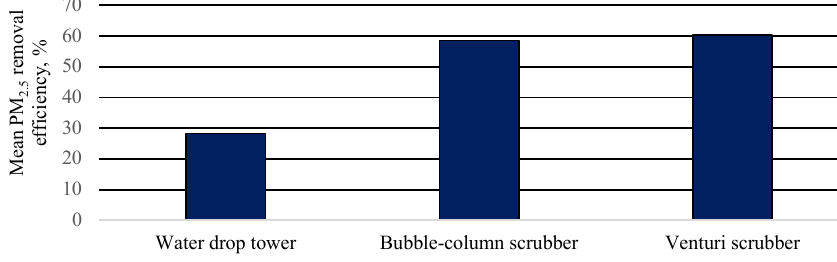
Fig. 2. PM 2.5 removal efficiency of different types of wet scrubbers